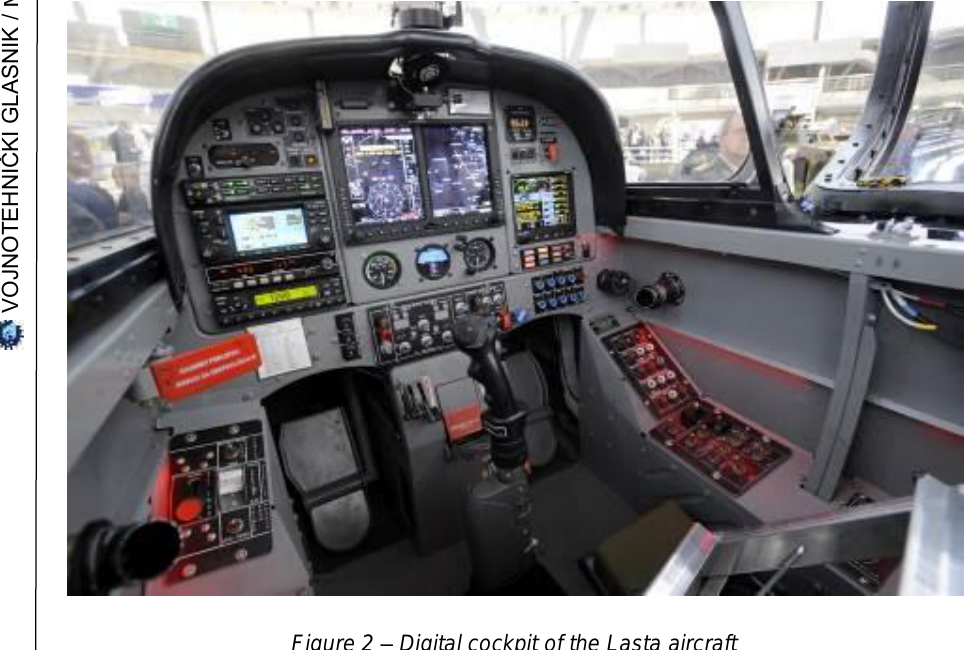
Figure 2 – Digital cockpit of the Lasta aircraft Рис. 2 – Стеклянная кабина самолета „Ласта“ Слика 2 – Дигитални кабински простор авиона „ ласта